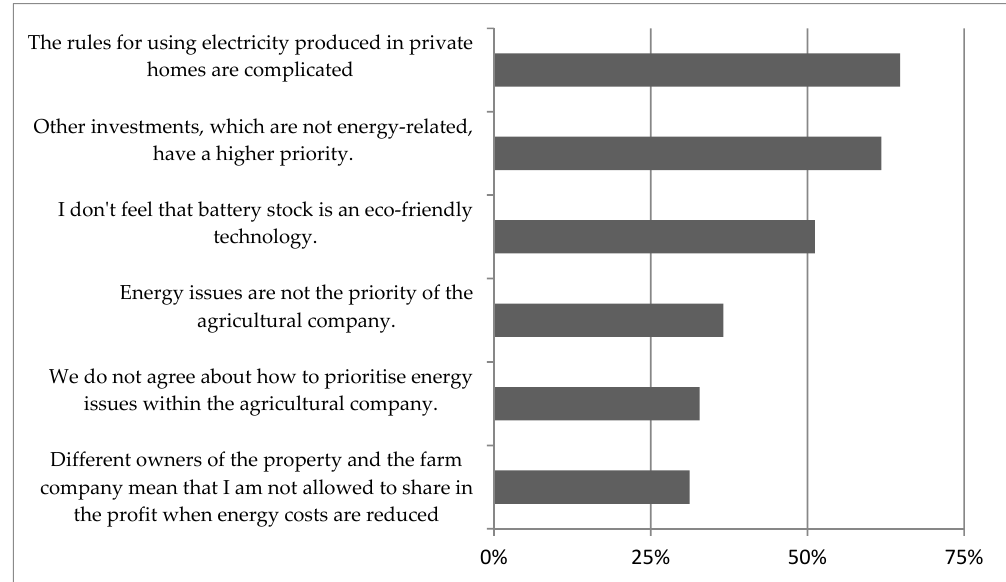
Figure 1. Some general energy-related questions regarding modern agriculture. The x-axis is graded from “takes full distance” (0) to “fully agree” (1) with the